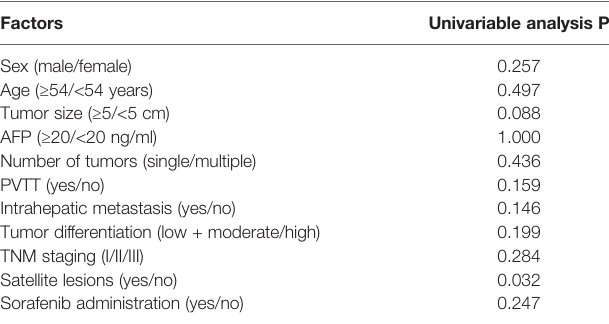
TABLE 3 | Univariable analyses of recurrence in patients with HCC after radical resection in the PSM cohort. Factors Univariable analysis